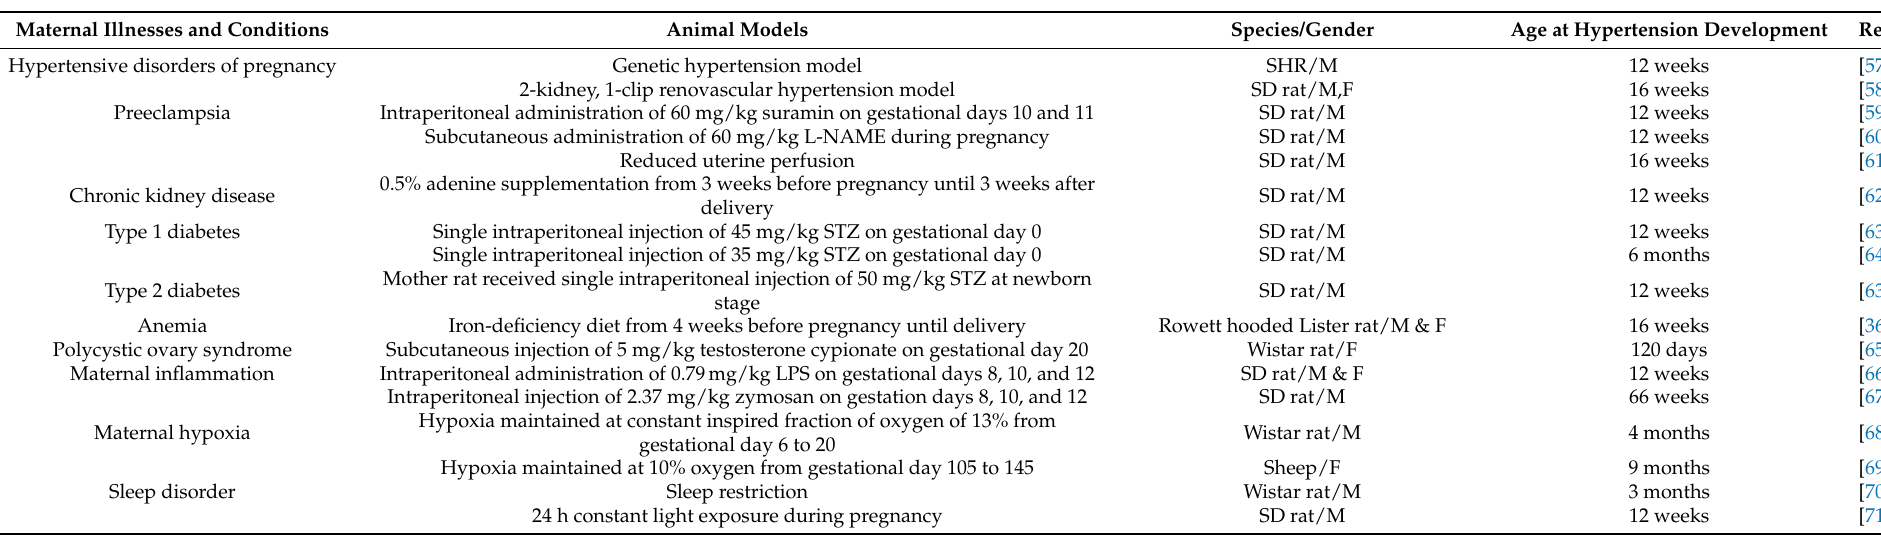
Table 1. Summary of animal models of the developmental programming of hypertension, categorized according to maternal illness and pregnancy